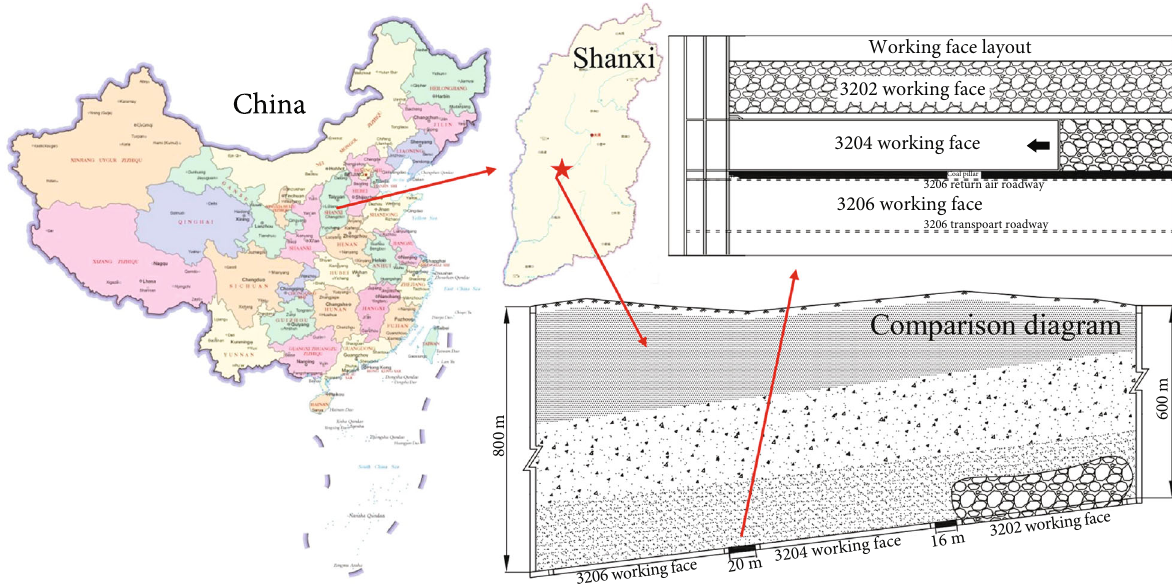
Figure 2: Layout of 3206 working